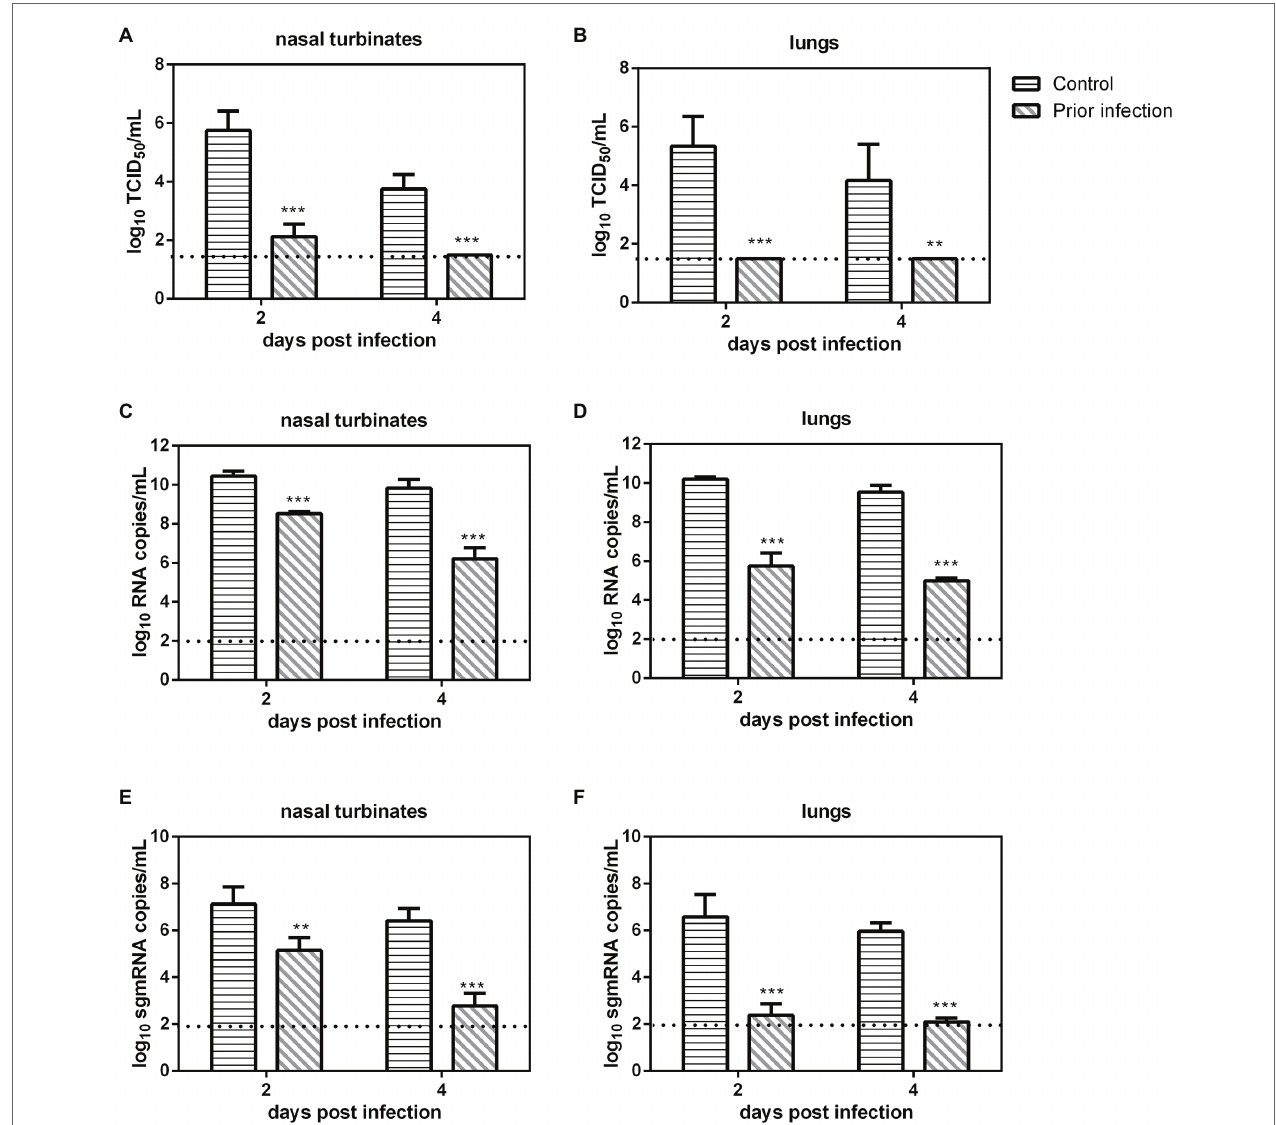
FIGURE 1 | Viral load in previously infected Syrian hamsters intranasally inoculated with severe acute respiratory syndrome coronavirus 2 (SARS-CoV-2). The dotted line represents the detection limit of viral titers and RNA copies. (A,B) Viral titers (log 10 TCID 50 /ml) detected in the nasal turbinates (A) and lungs (B) of previously infected Syrian hamsters challenged with SARS-CoV-2. (C,D) Viral RNA copies (log 10 RNA copies/ml) detected in the nasal turbinates (C) and lungs (D) of previously infected Syrian hamsters challenged with SARS-CoV-2. (E,F) Viral sgmRNA copies (log 10 sgmRNA copies/ml) detected in the nasal turbinates (E) and lungs (F) of previously infected Syrian hamsters challenged with SARS-CoV-2. ** p < 0.01; *** p <